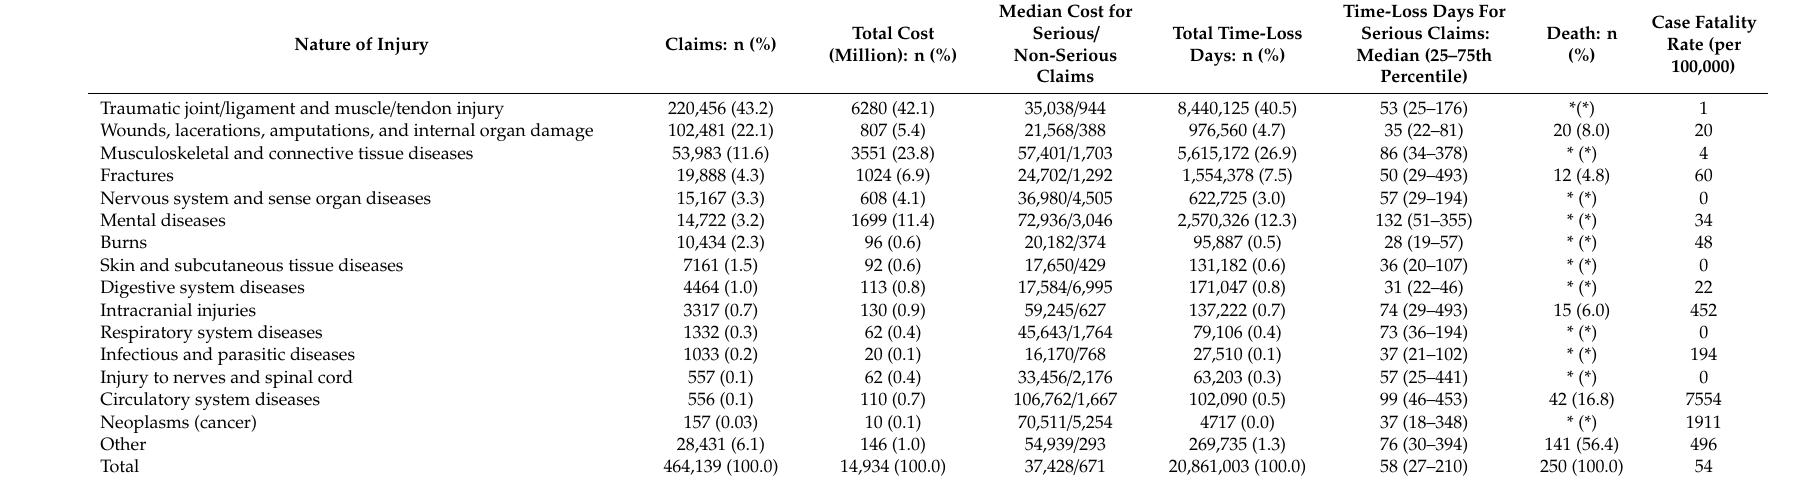
Median Cost for Time-Loss Days For Case Fatality Total Cost Serious / Total Time-Loss Serious Claims: Death: n Rate (per (Million): n (%) Non-Serious Days: n (%) Median (25–75th (%) 100,000) Claims Percentile)